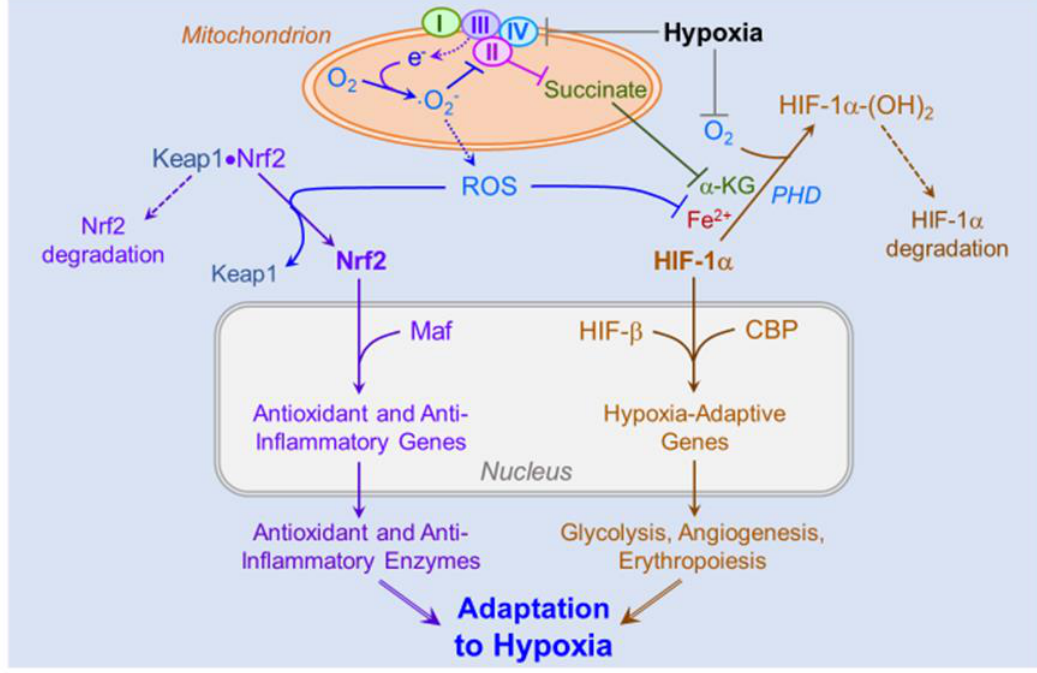
Figure 2. Parallel activation of Nrf2- and HIF-1-responsive gene programs by hypoxia. Hypoxia stabilizes HIF-1 α by depriving prolyl hydroxylase (PHD) of its substrate oxygen (O 2 ) and by causing electron (e-) accumulation within the mitochondrial respiratory complexes, leading to univalent reduction of O 2 yielding · O 2 − . The latter inactivates respiratory complex II, causing succinate to accumulate and inhibit PHD by competing with the PHD cofactor α -ketoglutarate ( α -KG). By increasing demand on the cell’s antioxidant defenses, · O 2 − and its ROS progeny hydrogen peroxide and peroxynitrite deplete ferrous iron (Fe 2+ ), an essential PHD cofactor, further stabilizing HIF-1 α to promote its nuclear translocation. In the nucleus, the α and β HIF subunits combine and, in collaboration with the coactivator CREB-binding protein (CBP), activate genes encoding numerous hypoxia-adaptive proteins, including glucose transporters, glycolytic enzymes, vascular endothelial growth factor and erythropoietin. · O 2 − and other ROS also liberate Nrf2 from Keap1, allowing Nrf2 to transmigrate to the nucleus, where it joins its coactivator Maf to activate the expression of an array of antioxidant and anti-inflammatory enzymes. Collectively, the products of HIF-1- and Nrf2-activated genes increase resistance to hypoxia-imposed oxidative stress, inflammation and ATP